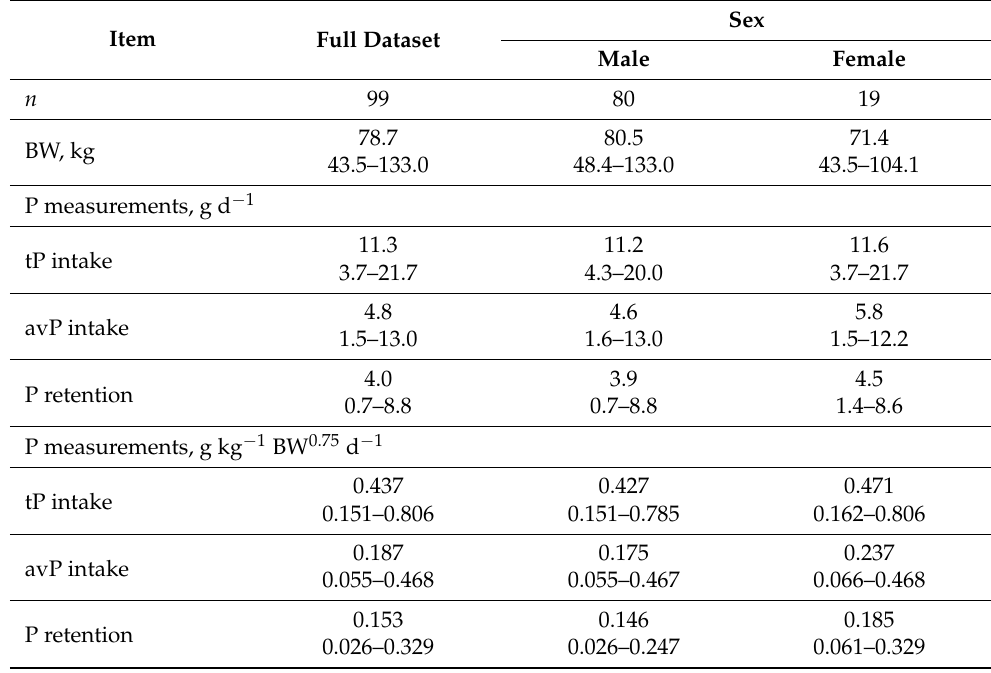
Table 1. Averages and minimum-maximum values of bodyweight (BW, kg), P intake and P retention values of the dataset in addition to being expressed on the basis of